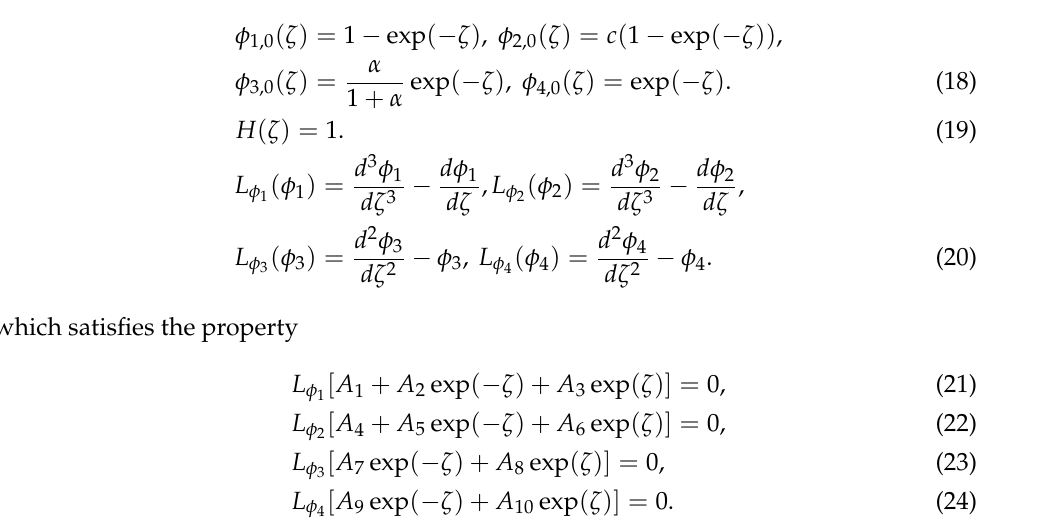
Figure 2. h -curve for φ (cid:48)(cid:48) The convergence value is tabulated in Table 1 for different orders of